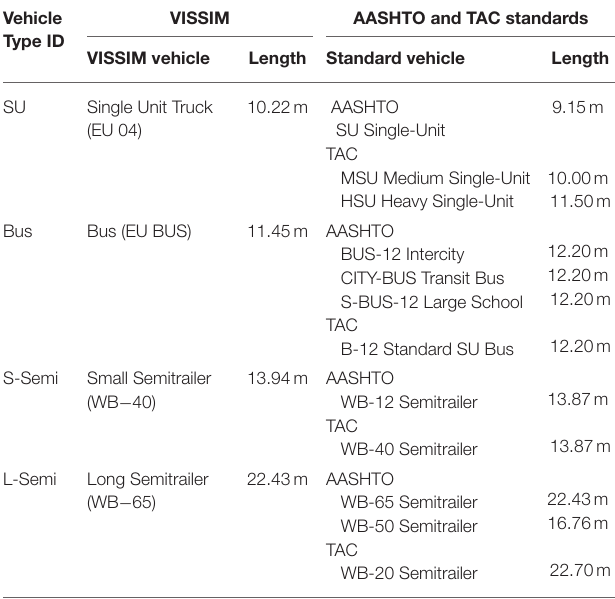
TABLE 2 | Heavy vehicles selected for testing and AASHTO and TAC standard vehicles. Vehicle Type